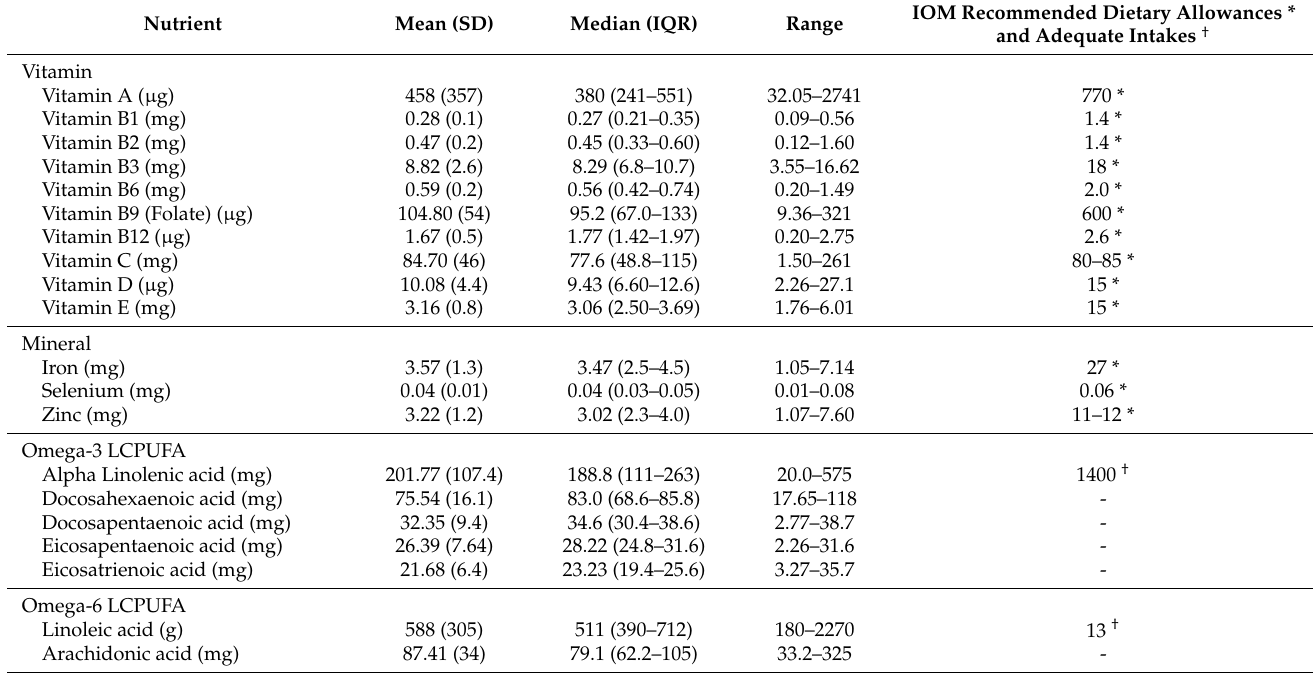
Table 2. Daily nutrient intake during Pregnancy in Projahnmo Cohort, Sylhet, Bangladesh ( n = 244). Nutrient Mean (SD) Median (IQR) Range